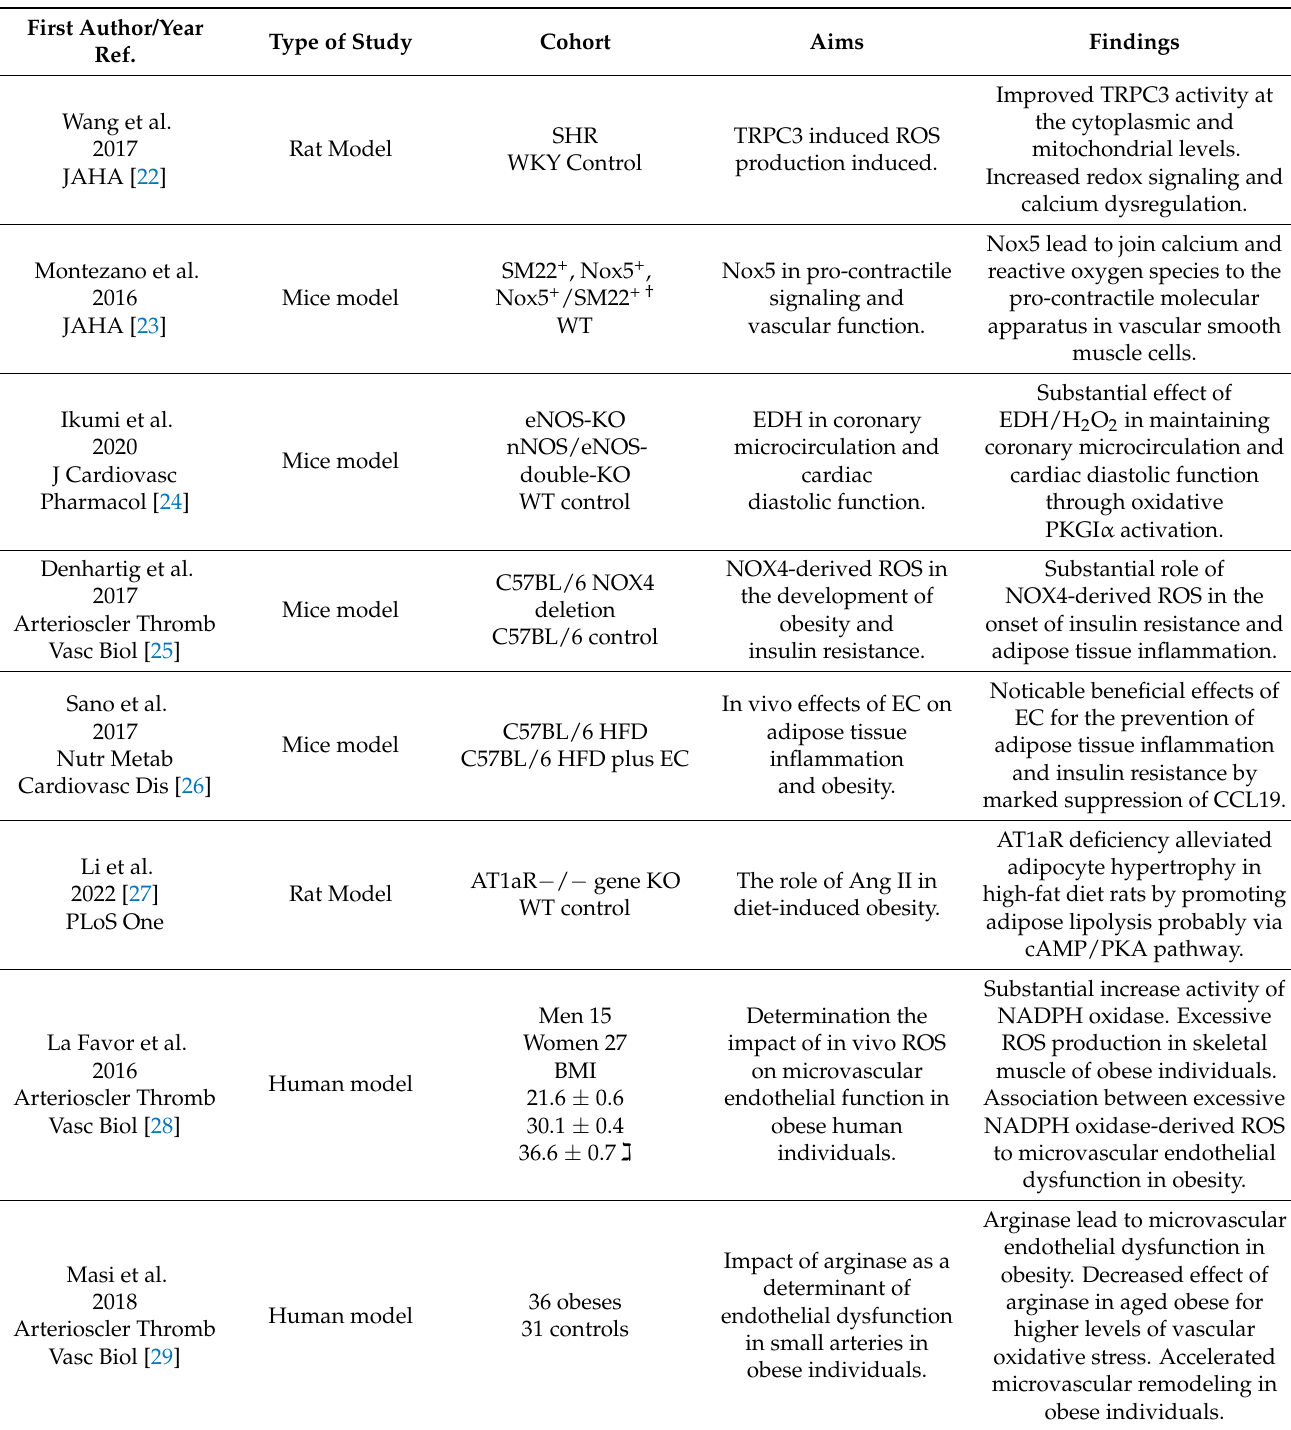
Table 1. Studies reporting the effect of ROS species. The references represent the progression in the text according to those reported in the PRISMA